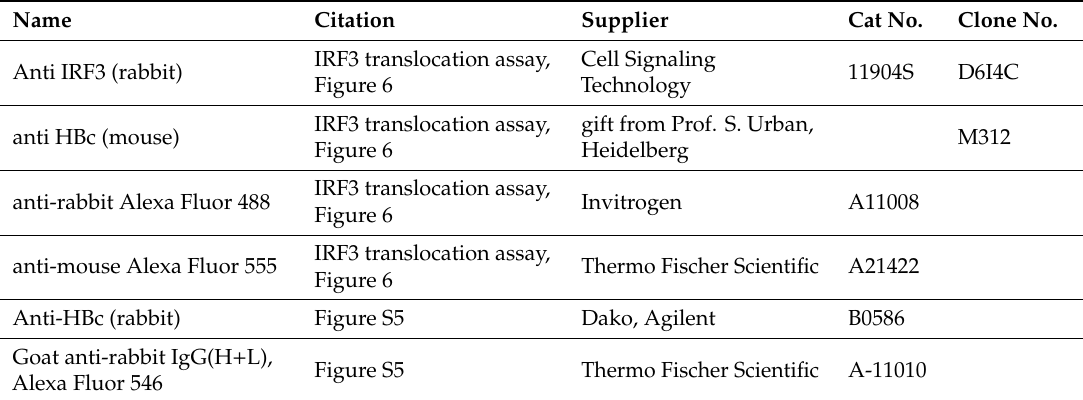
Table 5. Antibodies used for